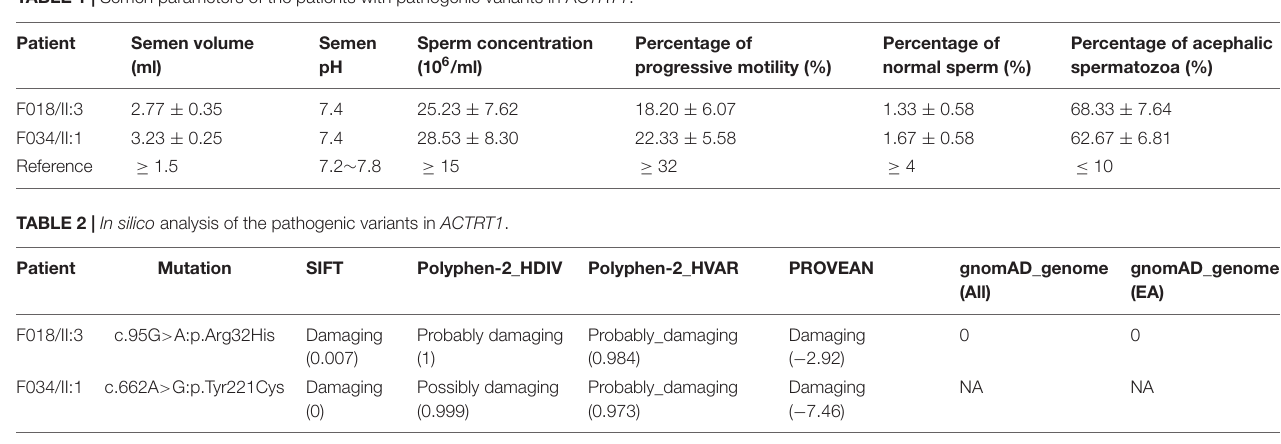
TABLE 1 | Semen parameters of the patients with pathogenic variants in AC TRT1 .